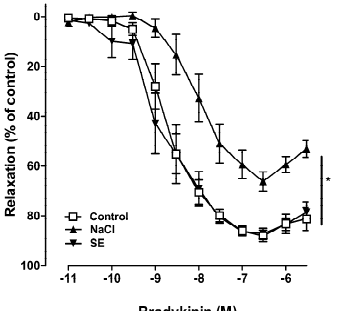
Figure 2. Relaxant responses to bradykinin in porcine coronary arteries following incubation for 18 h with a medium containing a high sodium concentration (160 mmol/L) or Salicornia europaea extracts (SE) at the concentration equivalent to 160 mmol/L sodium. Relaxant responses are expressed as the percentage of relaxation of the initial tone induced by U46619. Values are expressed as mean ± SEM from n = 6 to 10 experiments. Concentration-response curves were compared using two-way ANOVA. “*” stands for p < 0.05 vs. control.